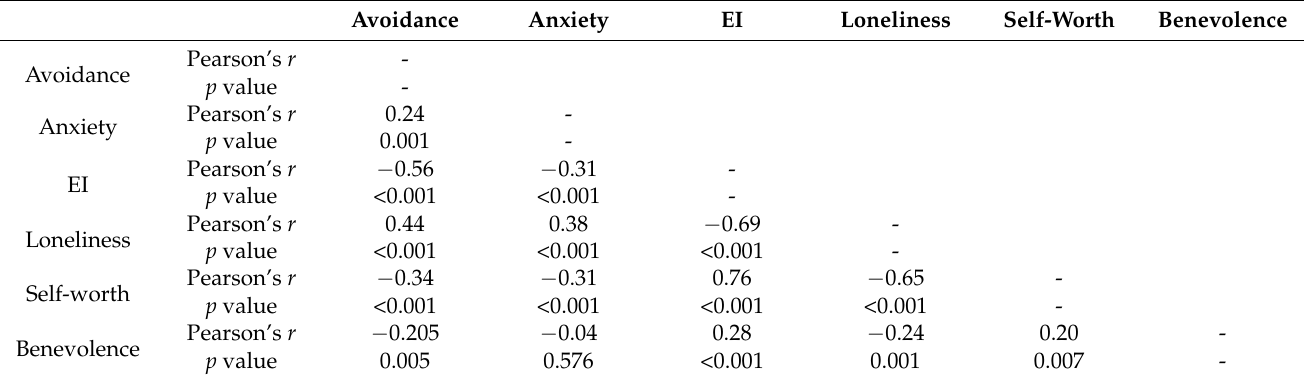
Table 4. Zero-order correlations between the variables (Study